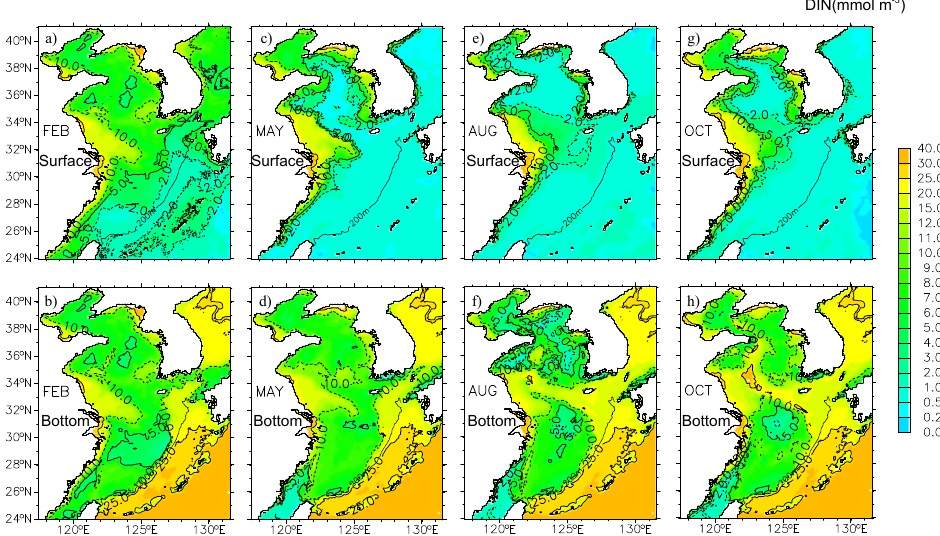
Fig.3 Fig. 3. Horizontal distribution of simulated DIN (mmolm − 3 ) at the surface (2m depth) and bottom layer (the deepest sigma layer) in four